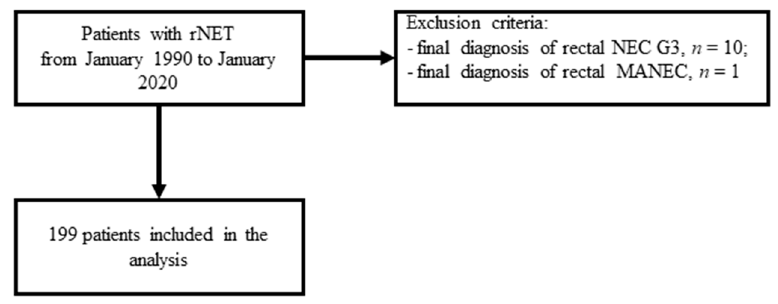
Figure 1. Study flow chart. rNET: rectal neuroendocrine tumor; NEC: neuroendocrine carcinoma; MANEC: mixed adenoneuroendocrine carcinomas.